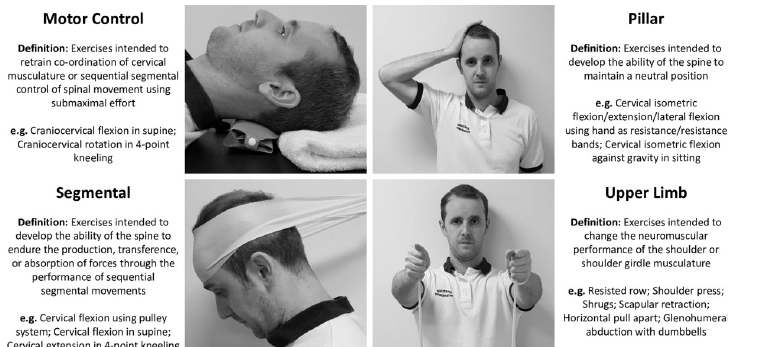
Fig 1. Exercise classification with example